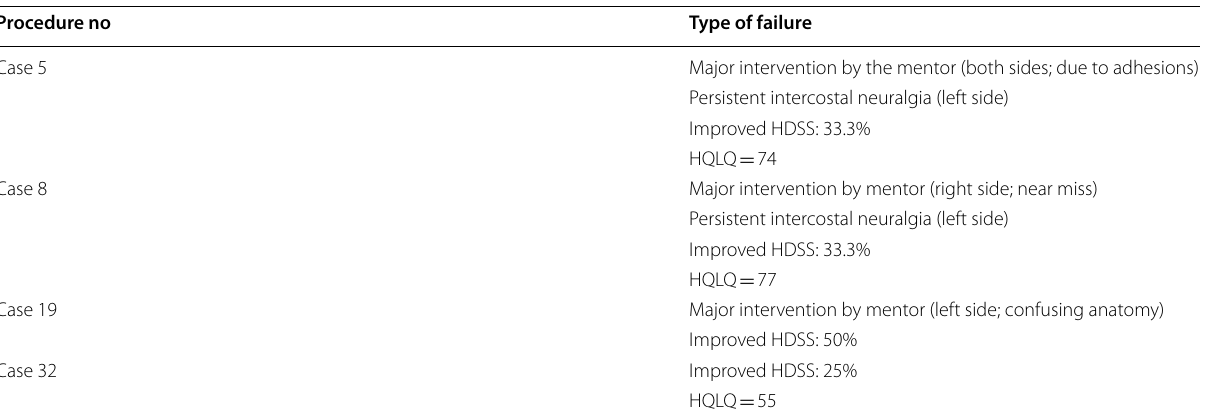
Table 3 Procedures with reported failures during the